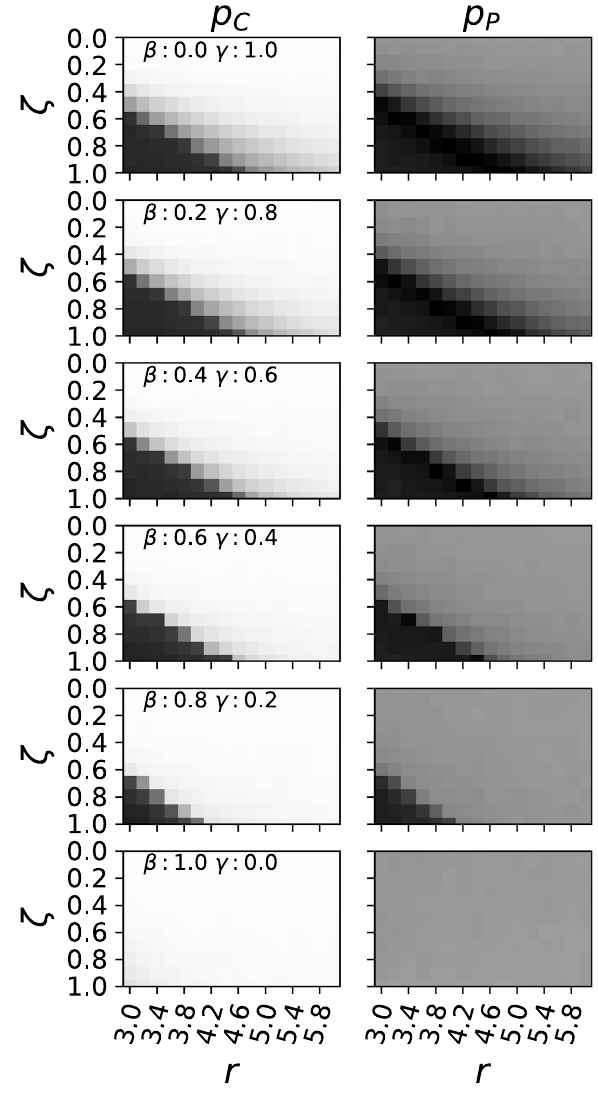
Figure 2. Phase diagrams for evolved strategies under varying conditions for punishment. From top to bottom: The punishment fine β was increased over six experiments from 0.0 to 1.0, while at the same time the cost of punishment γ was reduced from 1.0 to 0.0. The left column shows the probabilities to cooperate after evolution converged, on the right the same for the probability to punish. Everything else is identical to Fig.